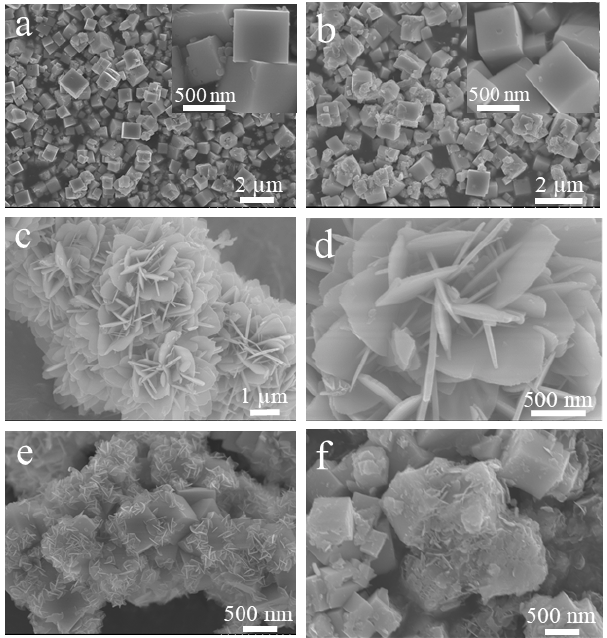
Figure 2. SEM images of NaTaO 3 ( a ), NTO-S ( b ), Sn 3 O 4 ( c , d ), Sn/NTO composites ( e ), and Sn/NTO-S ( f ), respectively.